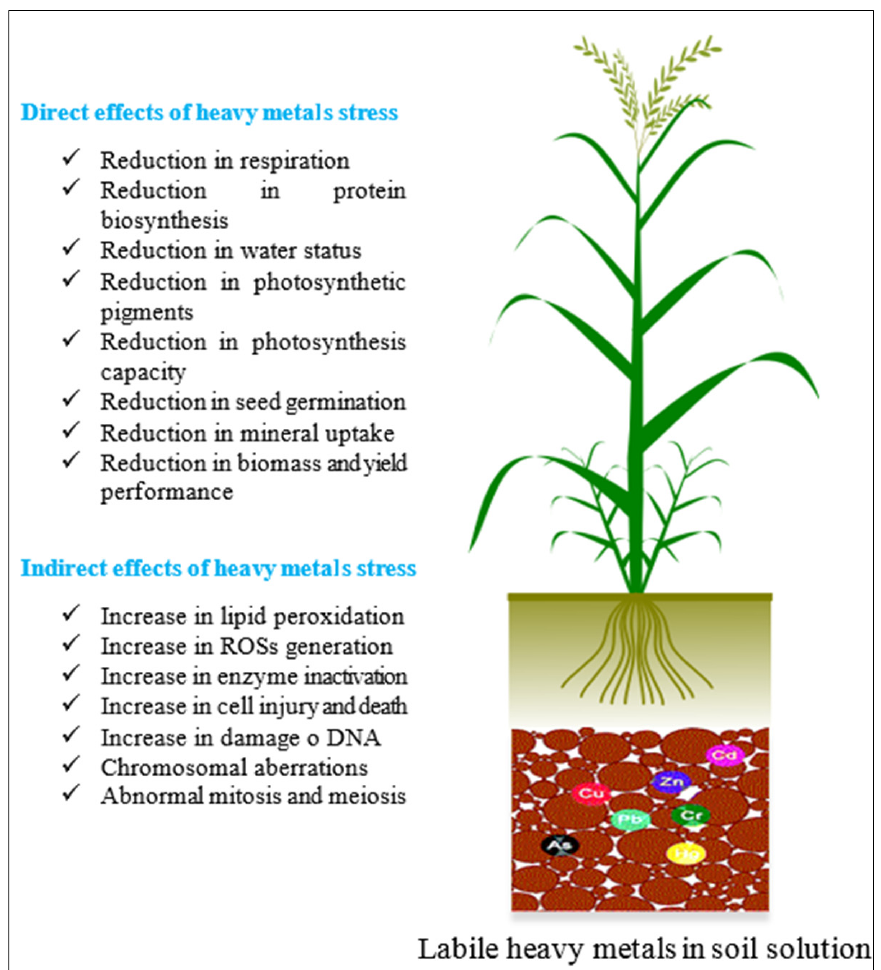
Figure 6. Heavy metal stress and its effects on plants.